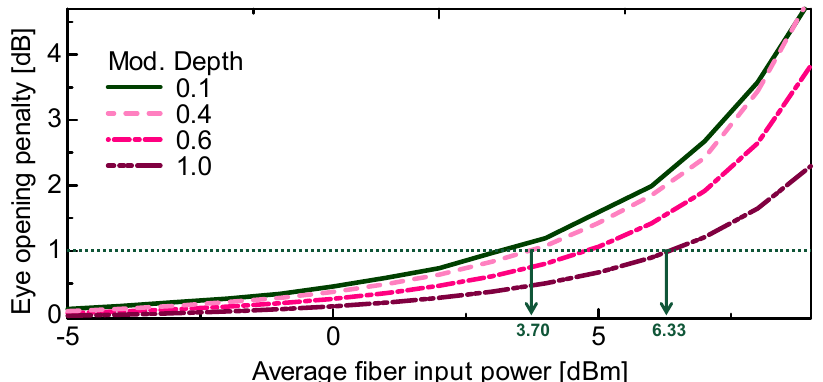
Figure 17. Eye-opening penalty of peak-clipped OSSB-SC signal ( V CL = V π ).